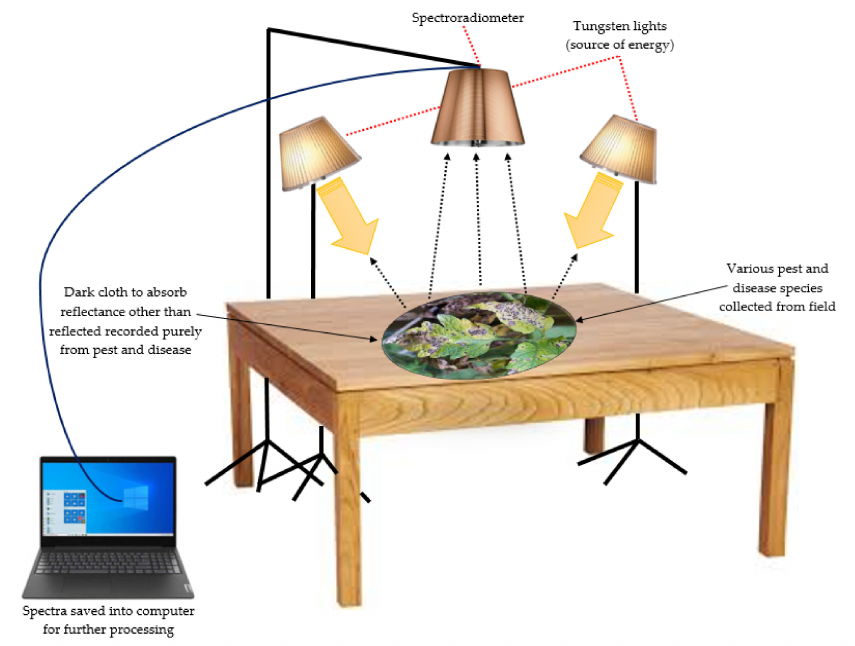
Figure 7. Configuration of spectral sampling in